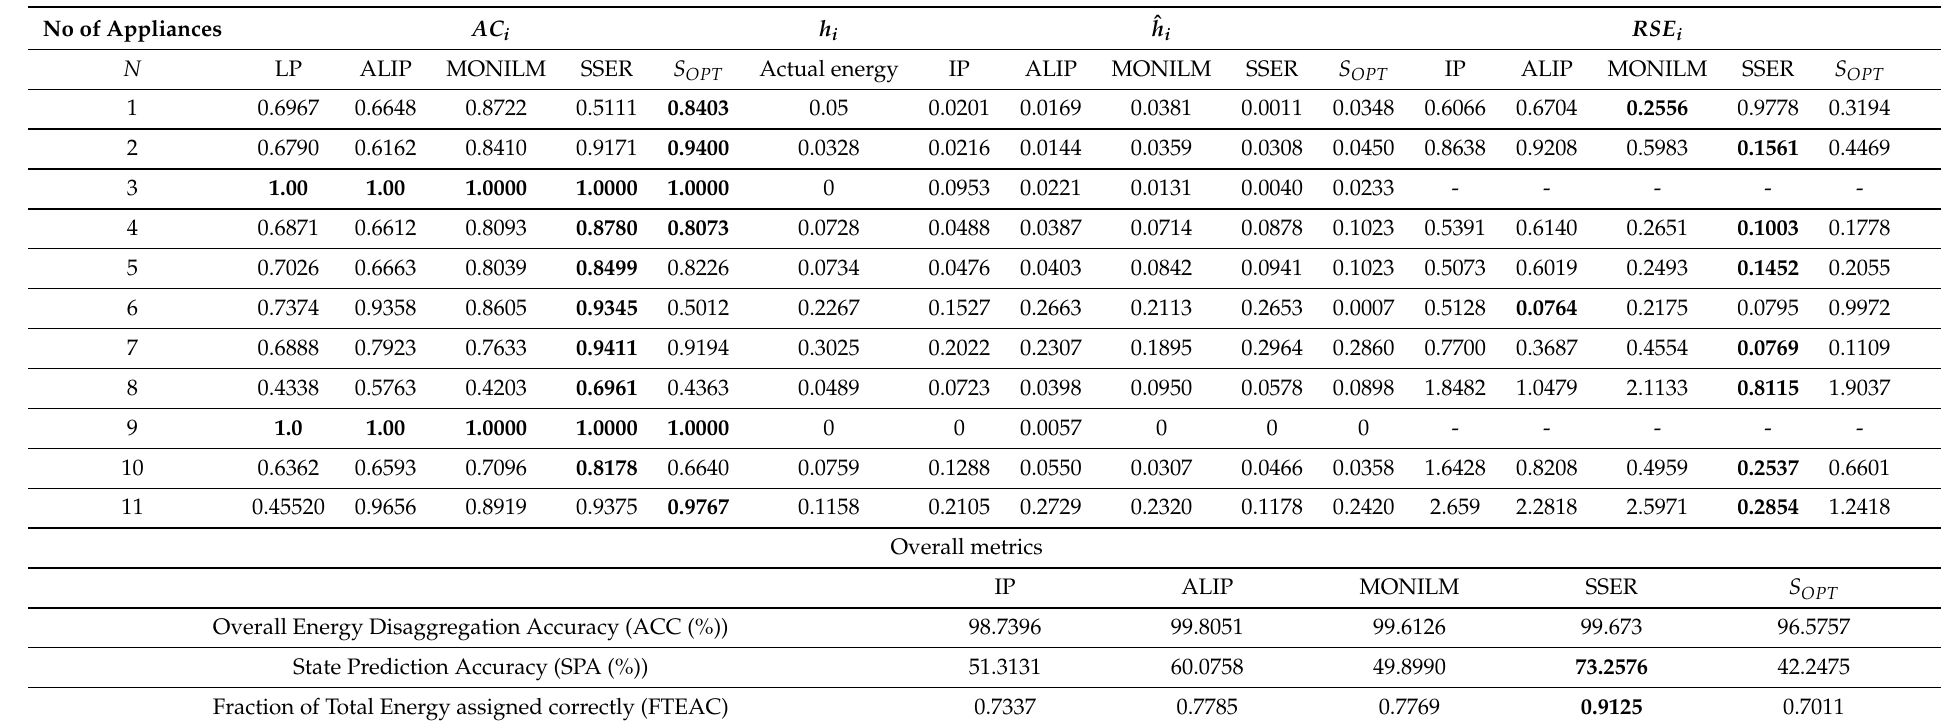
Table 3. Baseline results for instance I 1